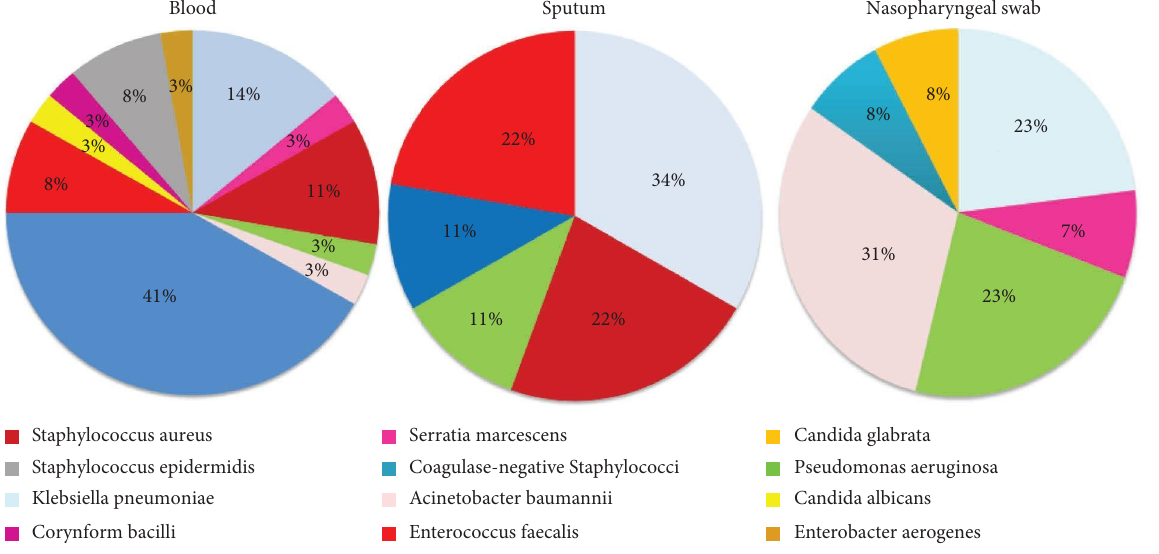
Figure 2: Bacterial and fungal coinfection distribution based on the type of specimen. Table 3: Microorganism distribution among diferent specimen types based on sex. Isolated